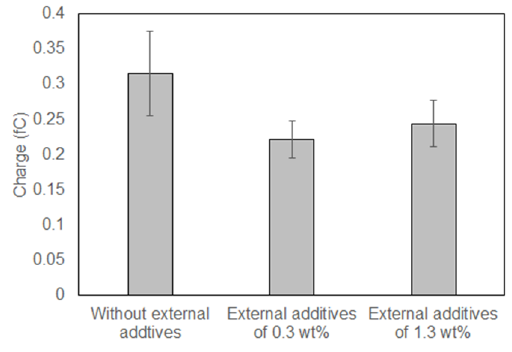
Figure 10. Charge calculation results for contact-electrified particles treated with different amounts of external additives. Error bars represent standard error.